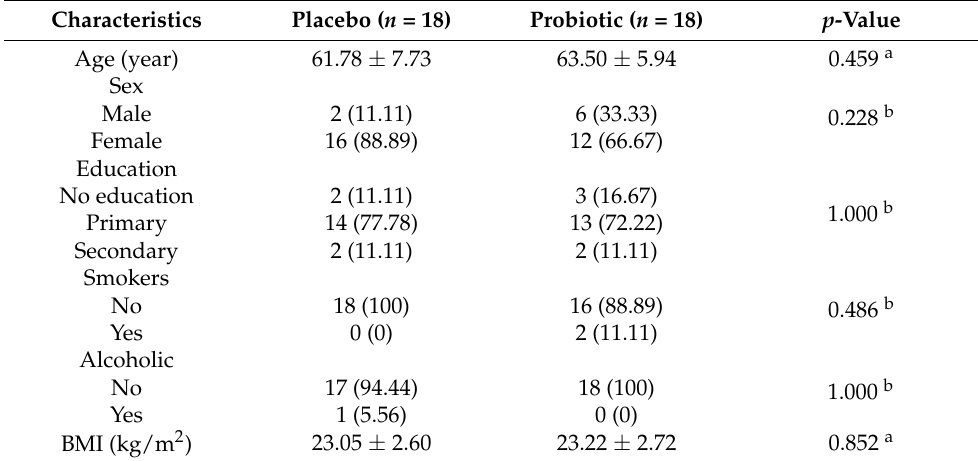
Table 1. General characteristics of the type 2 diabetes participants.